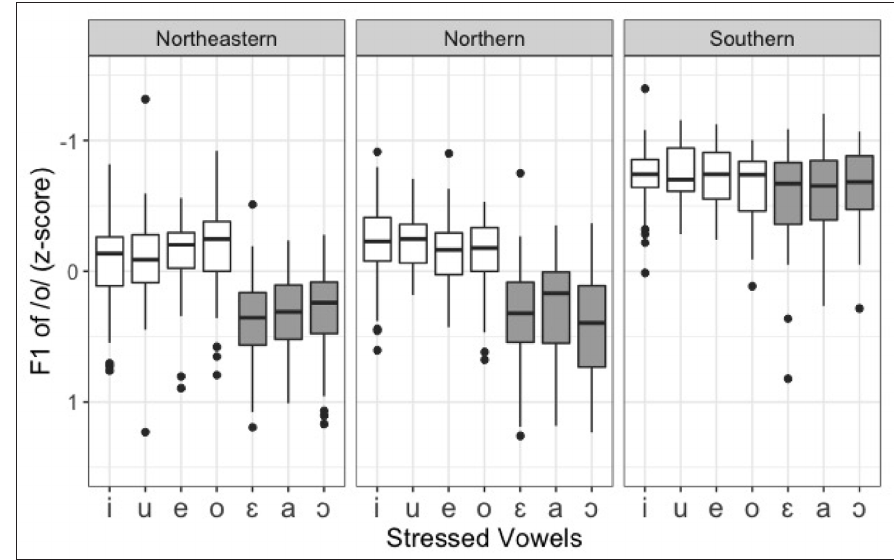
Figure 5: F1 (z-score) of /o/ as a function of the seven stressed vowels by dialect; white boxes = non-low vowels, grey boxes = low